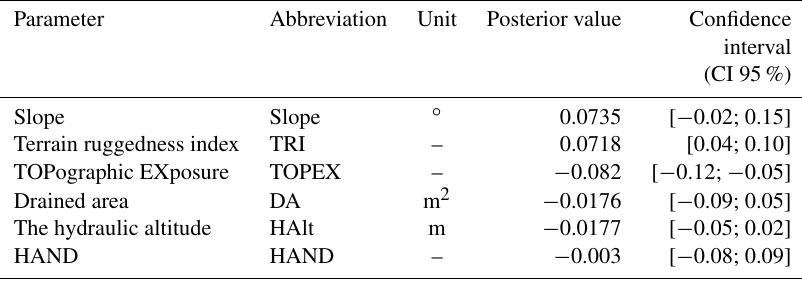
Table A2. List of environmental variables, abbreviations, units, and values of the posteriors in univariate models for a height threshold equal to the 0.001th percentile of the height distribution of the canopy.